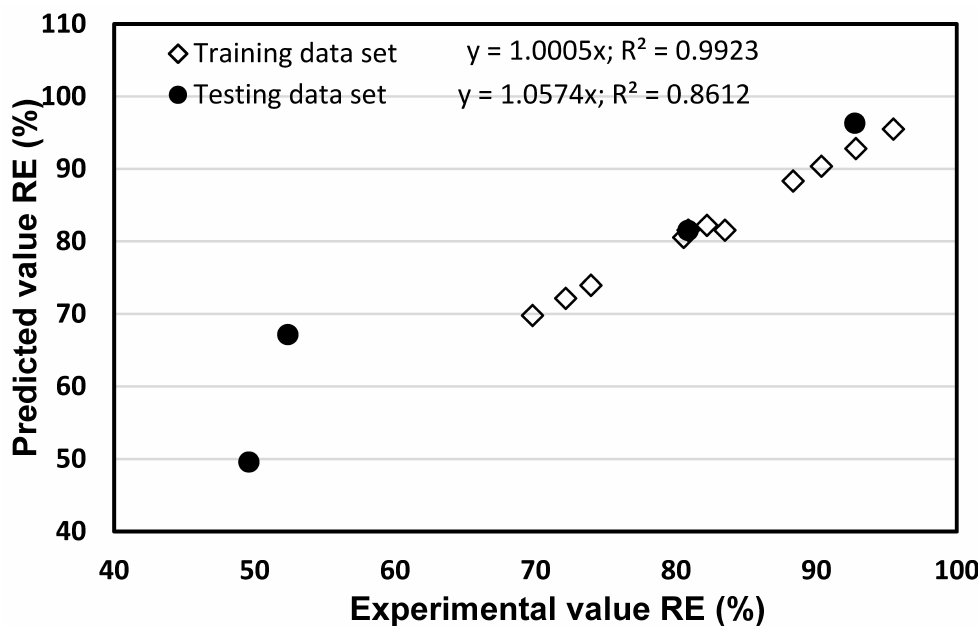
Figure 4. Experimental and predicted chromium (Cr) removal efficiencies using the ANFIS model.